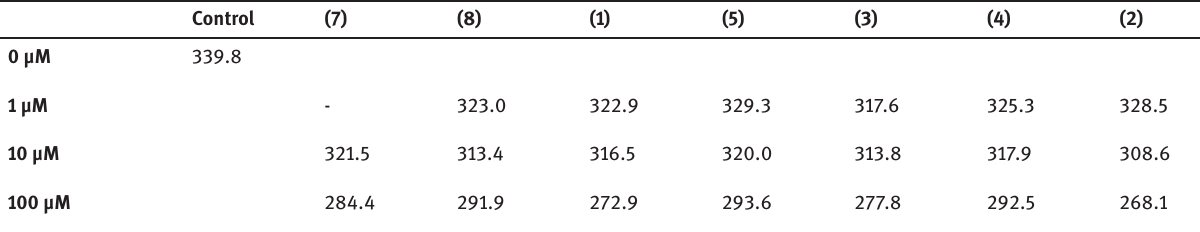
Table 5: The RNA MFI (mean fluorescence intensity) of PBL in G1 phase of cell cycle stained with AO and analyzed by flow cytometry. Control